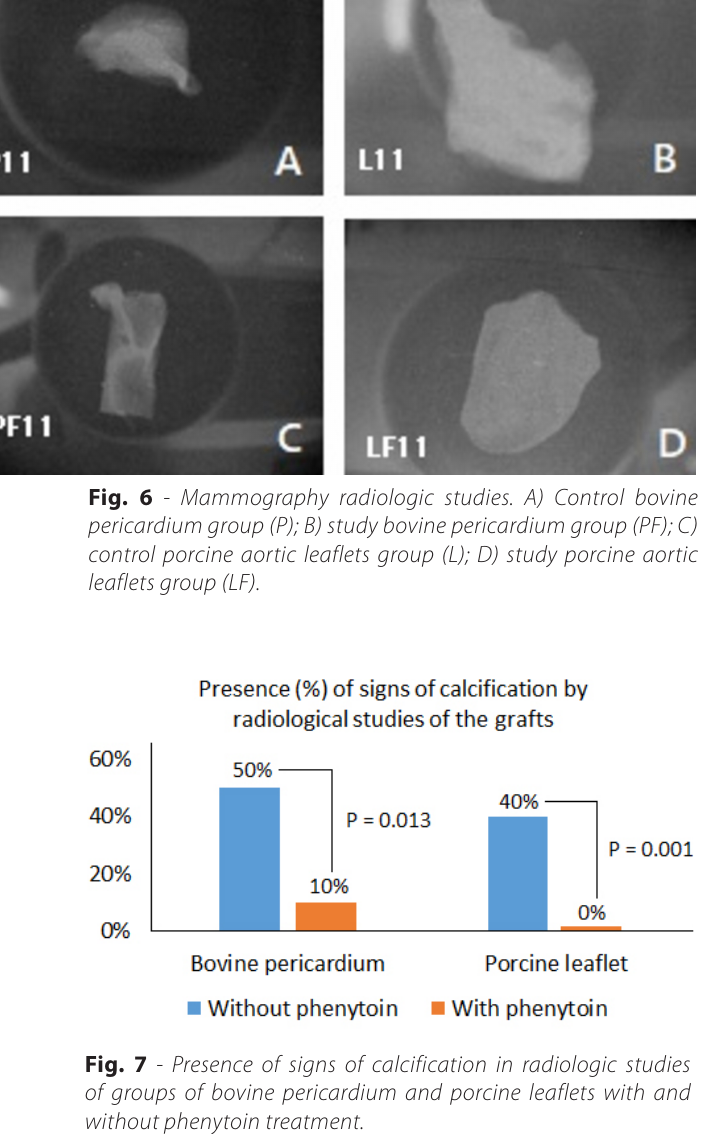
deposit is basically the same in both processes. A deposit of hydroxyapatite crystals occurs initially in the matrix and, after exposure of these crystals to extracellular fluid, forms calcium crystals and later attracts the arrival of connective tissue, particularly collagen. These crystals become niche nurseries for the accumulation of more calcium crystals. Increased deposition of calcium crystals in active medullary formation depends on the availability of calcium and orthophosphate in extracellular fluid, and possibly the presence of collagen, which can be changed or delayed by the presence of natural mineralization inhibitors, such as proteoglycans, osteocalcin, phosphoproteins, and β-2- glycoprotein [11,13] .